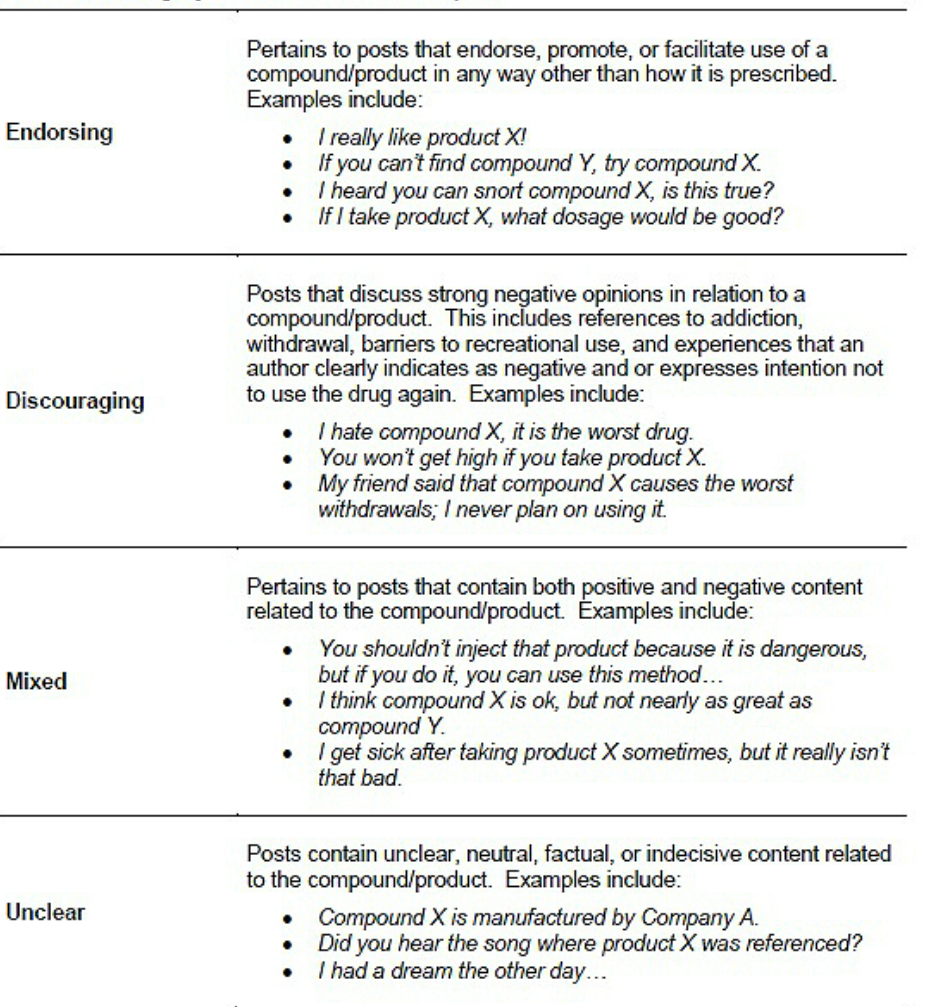
Figure 1. Abuse-related sentiment categories in formal content